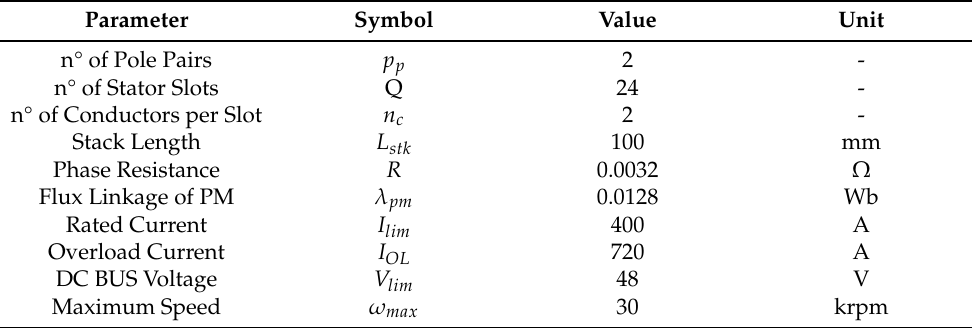
Table 1. Main parameters of the reference IPM synchronous